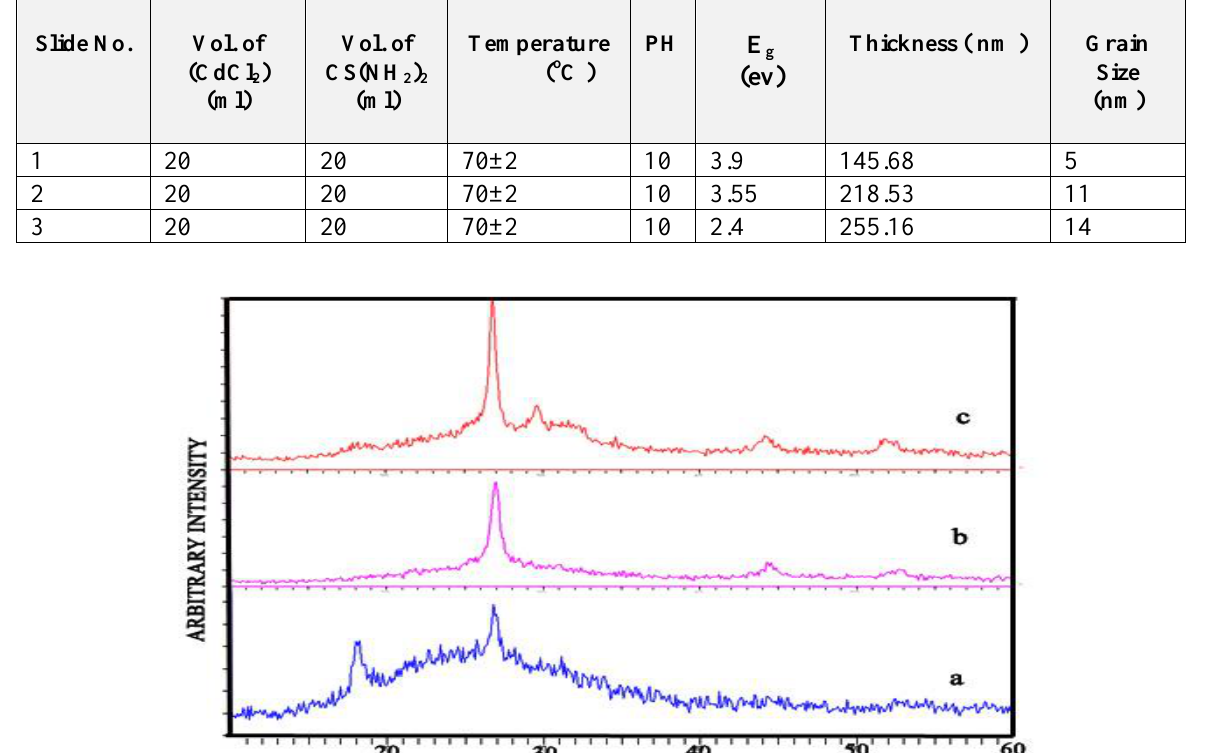
Table 1: The varying of grain size with different thicknesses.